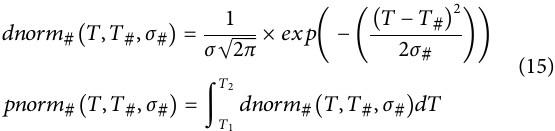
(Figure 12): 1) mechanical damage (MD): damage induced during operational conditions and under their service loads, and 2) FD: induced during thermomechanical cycles. The MD de fi nition helps to identify lifetime- and reliability-related issues, while FD can be used to characterize SMP programming and shape recovery